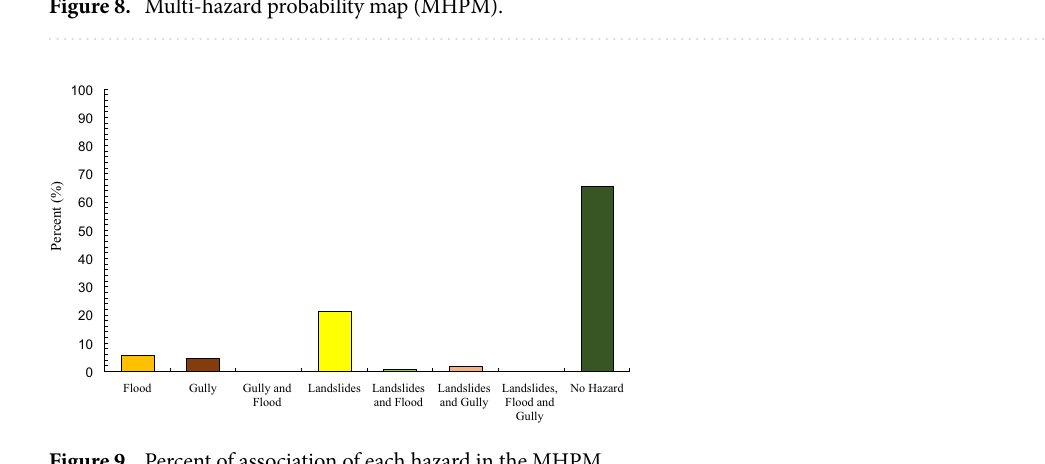
Figure 9. Percent of association of each hazard in the